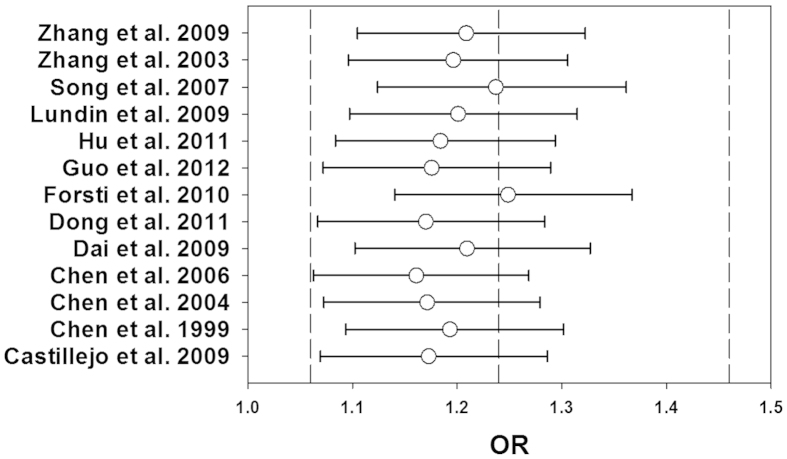
Results of leave-one-out method using dominant model.The circles and the horizontal lines represent the ORs and 95% CIs after
omitting studies in turn. The vertical dashed lines show the ORs of 1.06,
1.24 and 1.46.